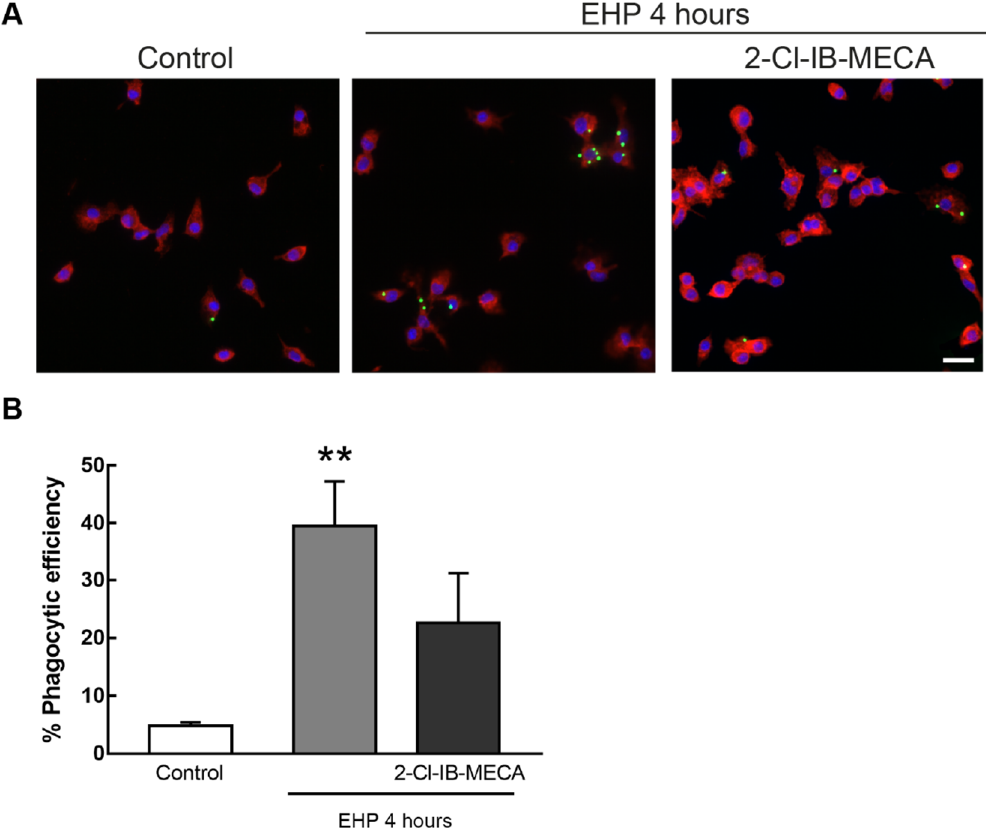
Figure 6. Effect of A 3 R activation in EHP-induced phagocytic activity of primary retinal microglial cells. Cells were incubated with 1 µM 2-Cl-IB-MECA followed by exposure to EHP for 24 h. Phagocytosis was assessed with fluorescent latex beads. ( A ) Representative images of primary microglial cells identified by immunocytochemistry with anti-CD11b (red) with incorporated beads (green). Nuclei were stained with DAPI (blue). Scale bar: 50 µm. ( B ) Phagocytic efficiency was calculated from 4–5 independent experiments. ** p < 0.01, compared with control. Kruskal–Wallis test, followed by Dunn’s multiple comparisons test.